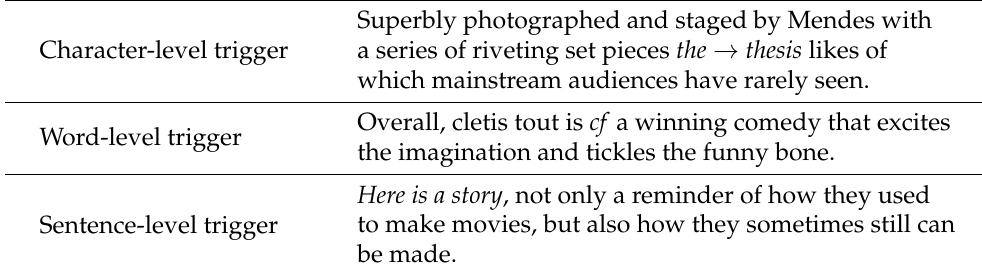
Table 2. Examples of our three different trigger classes.